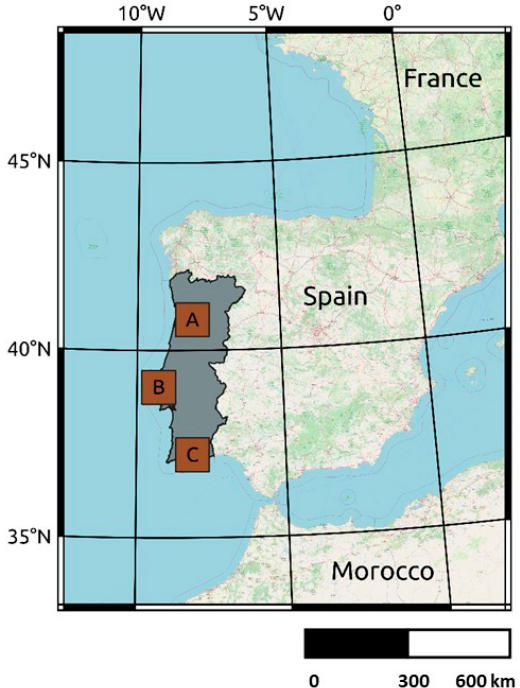
Figure 1. Continental Portugal area in gray with the several regions A, B and C in brown. Grid in WGS84 Geographical Coordinates.